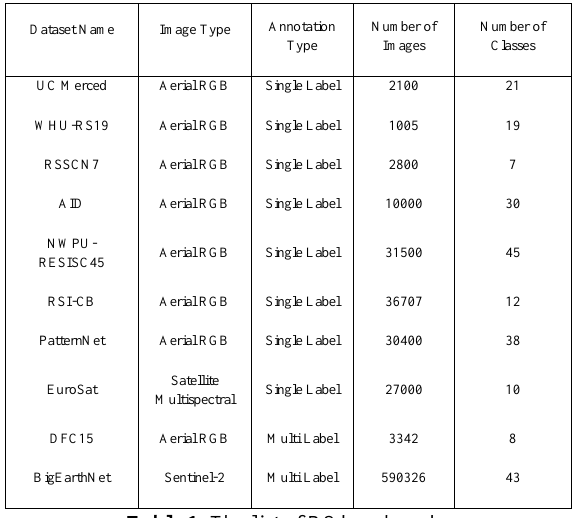
Table 1 . The list of RS benchmarks